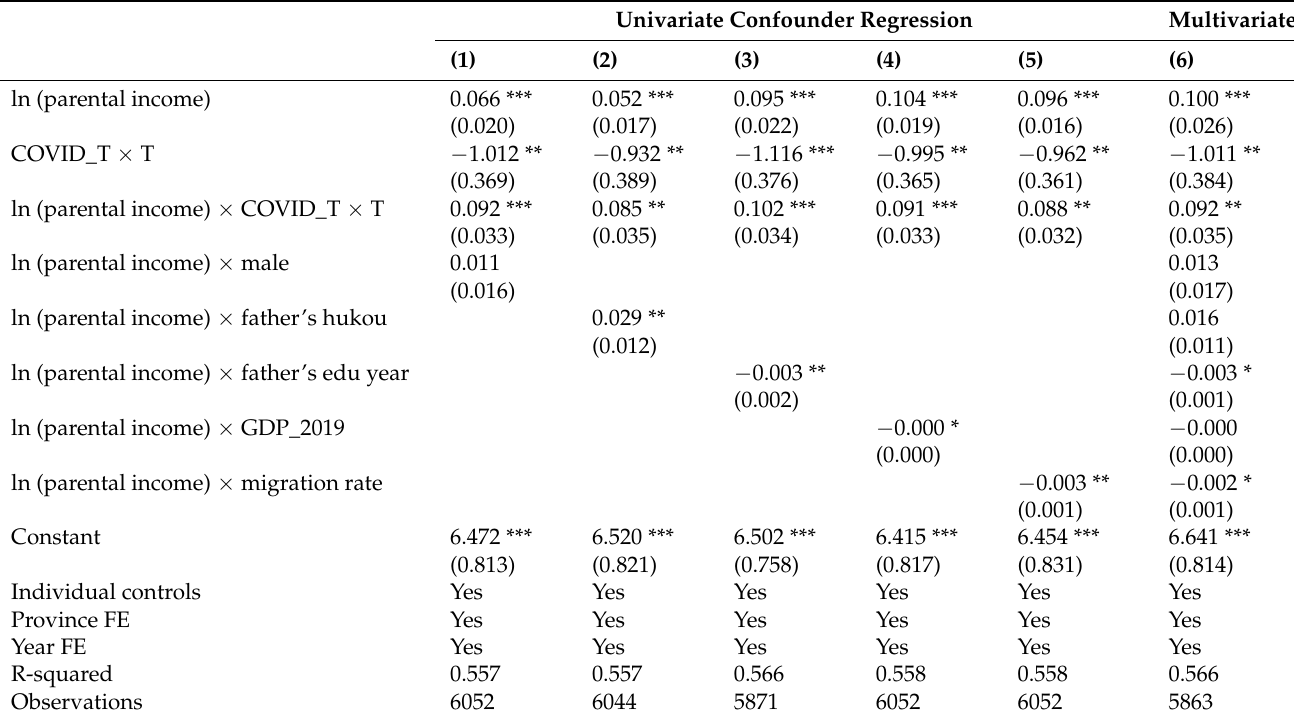
Table A5. Including family- and province-level confounders with total COVID-19 intensity